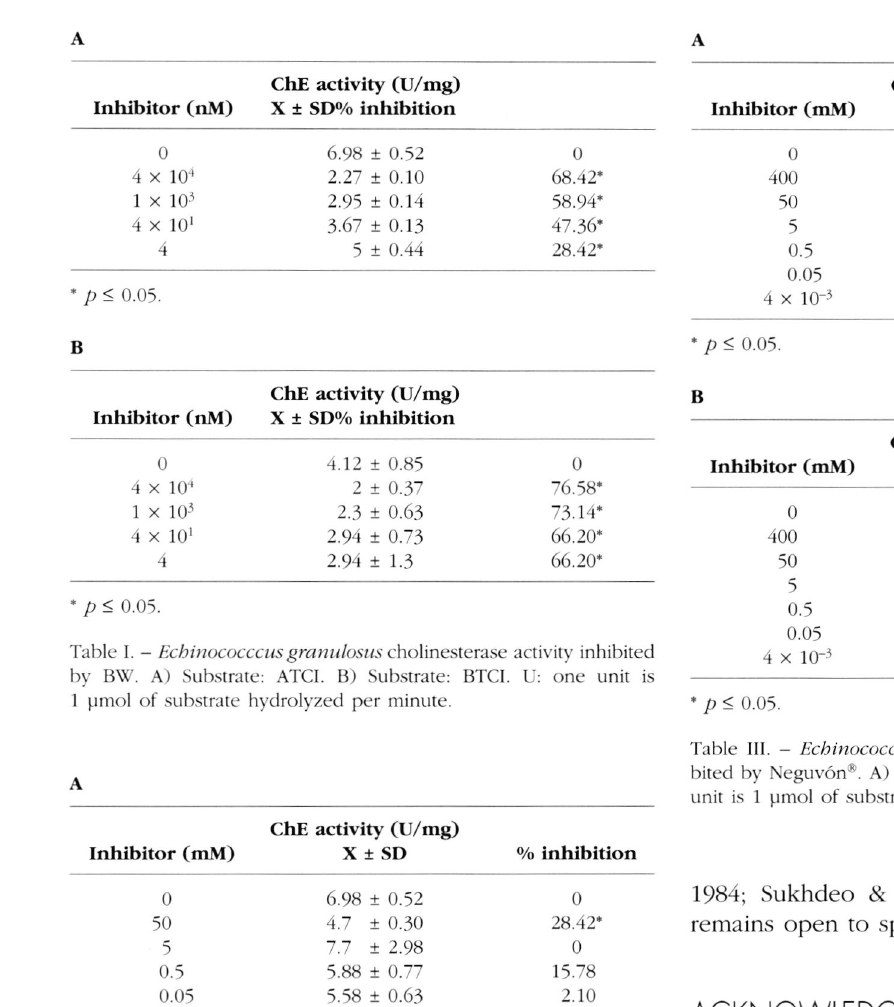
Table I. - Echitiococccus granulosus Cholinesterase activity inhibited by BW. A) Substrate: ATCI. B) Substrate: BTCI. U: one unit is